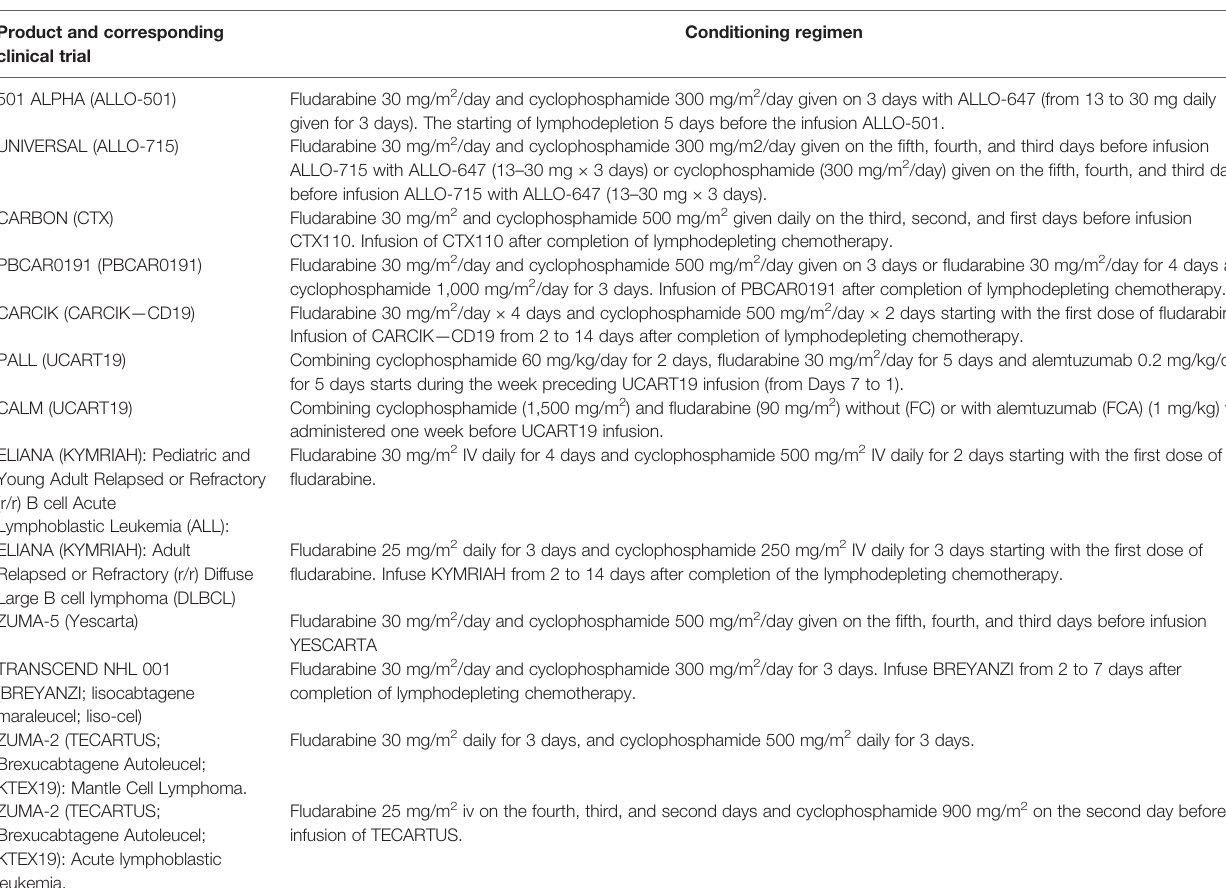
TABLE 2 | Conditioning regimes administered in clinical trials of autologous and allogeneic CAR-T products. Product and corresponding clinical